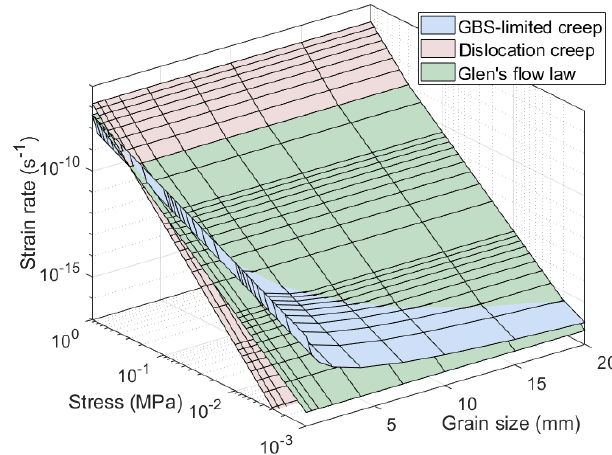
Figure 4. The effect of grain size and stress on calculated strain rate plotted for Glen’s flow law and the dislocation creep mechanism and GBS-limited creep of the composite flow law at a constant temper- ature of 243K using the flow law parameters in Table